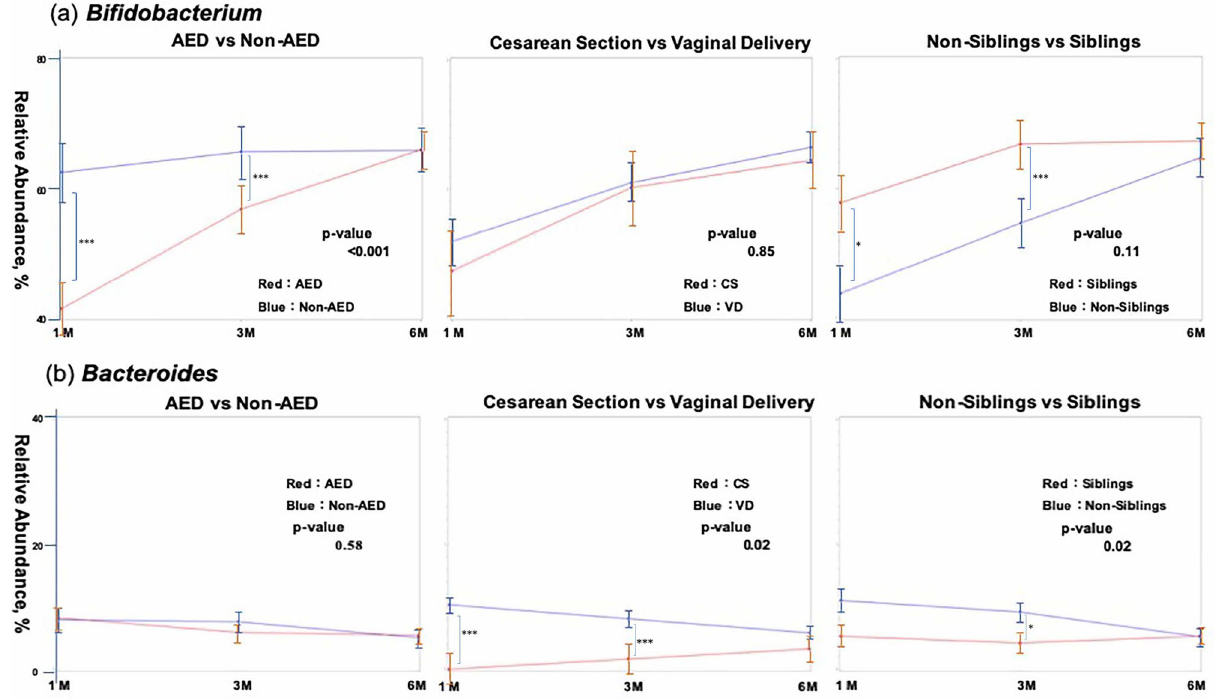
Figure 7. Time-course changes in bifidobacterial ( a ) and Bacteroides ( b ) occupancies (from 1 to 6 months after birth) based on AED or non-AED, delivery method, and the presence or absence of siblings, using a linear mixed-effect model. The analysis set at 1 month included 130 infants. Dropouts at 3 and 6 months were handled as missing values. The standard deviation by age in months is shown in bar form in each figure. Significant differences in occupancies between the two groups at each time point are also indicated in each comparison. The significance level was set at 5%. * p < 0.05, *** p < 0.001 using the Mann–Whitney U-test. This figure was generated using SAS version 9.4 (https